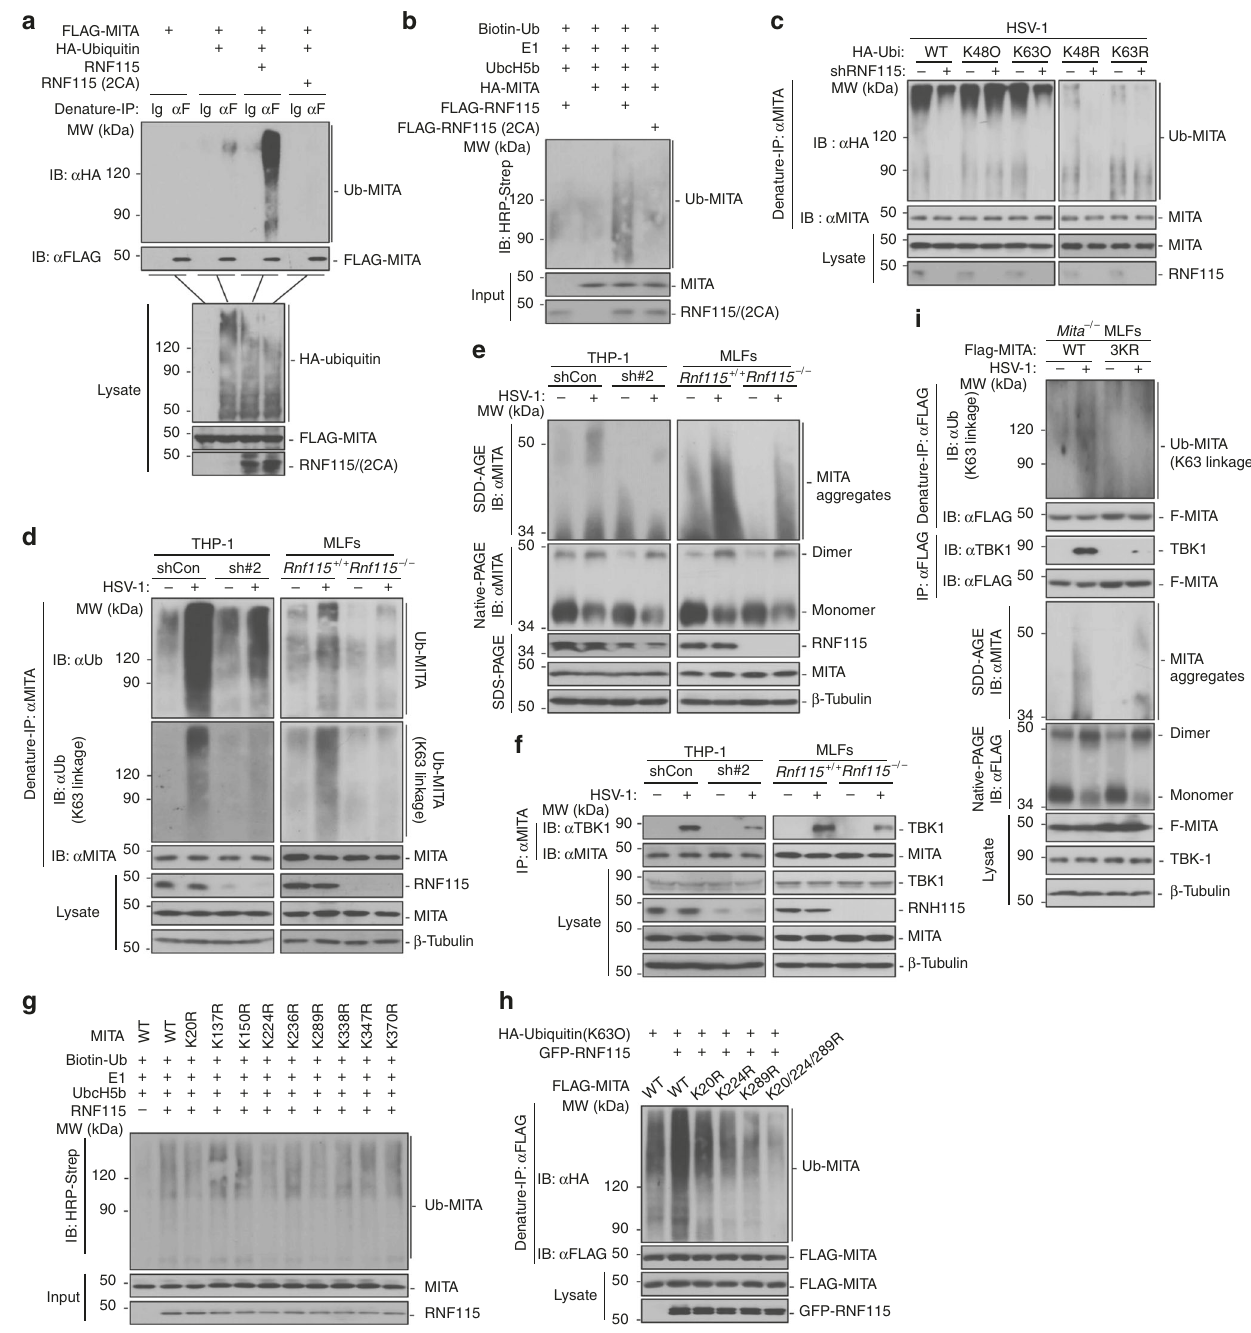
Fig. 7 RNF115 interacts with and catalyzes K63-linked ubiquitination of MITA after HSV-1 infection. a Denature-IP (with control IgG or anti-FLAG) and immunoblot analysis (with anti-HA, FLAG, or RNF115) of HEK293 cells transfected with the indicated plasmids for 24 h. b In vitro ubiquitination analysis of MITA. c Denature-IP (with anti-MITA) and immunoblot analysis (with anti-HA, MITA, or RNF115) of THP-1 cells stably shCon or shRNF115#2 that were transfected with plasmids encoding HA-Ubiquitin or HA-Ubiquitin mutants (K48O, K63O, K48R, K63R) followed by HSV-1 infection for 6 h. d , e Denature- IP (with anti-MITA) and immunoblot analysis (with anti-Ub, K48-linkage polyubiquitin, MITA, RNF115, or β -Tubulin) ( d ) or SDD-AGE analysis of the aggregation of MITA, native-PAGE analysis of the dimerization of MITA and SDS – PAGE analysis of the indicated proteins ( e ) in THP-1 cells stably transfected with shCon or shRNF115#2 or in Rnf115 + / + and Rnf115 − / − MLFs infected with HSV-1 for 0 – 6 h. f Immunoprecipitaion (with anti-MITA) and immunoblot analysis (with anti-MITA, TBK1, RNF115, or β -Tubulin) in THP-1 cells stably transfected with shCon and shRNF115#2 (left panels) or in Rnf115 + / + and Rnf115 − / − MLFs (right panels) infected with HSV-1 for 0 – 6 h. g In vitro ubiquitination analysis of ubiquitin-modi fi ed MITA or MITA mutants. h Denature-IP (with anti-FLAG) and immunoblot analysis (with anti-FLAG, HA, or GFP) in HEK293 cells transfected with plasmids encoding FLAG-MITA or mutations, HA-Ubiquitin, empty vector and GFP-RNF115 for 24 h. i Denature-IP (with anti-FLAG, upper two panels), immunoprecipitation (with anti-FLAG, middle two panels), and immunoblot analysis (with antiK63 linkage polyubiquitin, FLAG, or TBK1), SDD-AGE analysis (with anti-FLAG or β -Tubulin, middle panels) or native-PAGE analysis (with anti-FLAG) in Mita − / − MLFs reconstituted with MITA or MITA(3KR) followed by infection with HSV-1 for 0 – 6 h. Data are representative of three ( a – c ) or two ( d – i ) independent experiments. Source data are provided as a Source Data fi